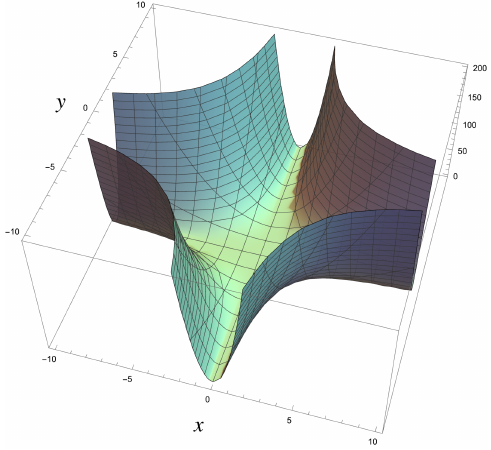
Figure 6 . The shape of the potential x 2 y 2 / 2 .